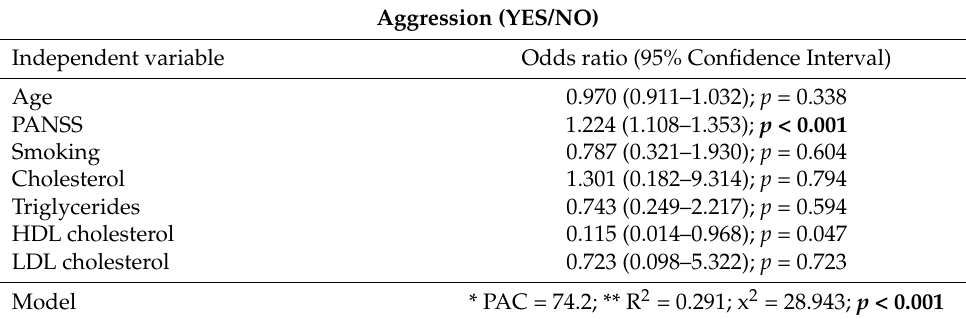
Table 4. Aggression in patients with schizophrenia depending on age, severity of symptoms of schizophrenia (PANSS), smoking, and lipid